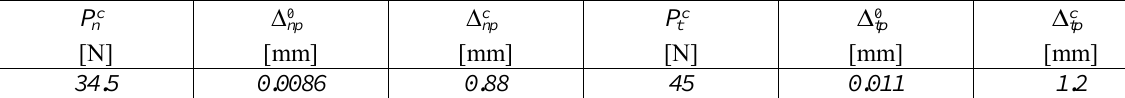
Geometrical and mechanical properties of the